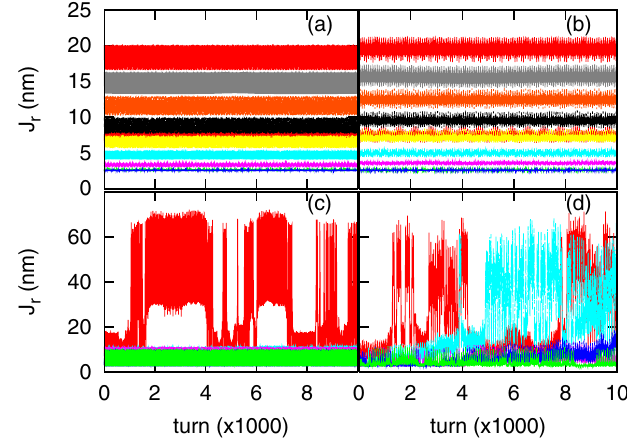
(cid:5) 0 , (b) (cid:12) (cid:5) s (cid:5) s